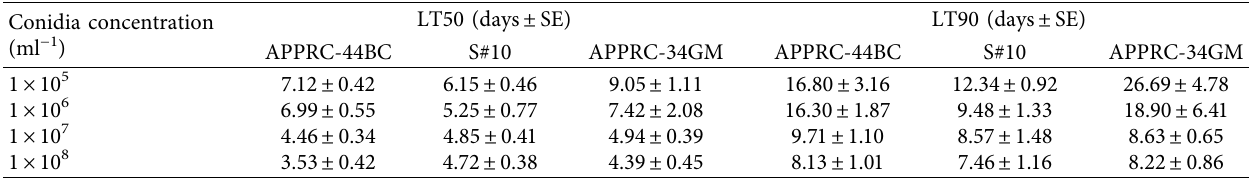
Figure 1: Mean percentage mortality of Chilo partellus larvae due to selected entomopathogenic fungi (EPF) strains. Isolates with ∗ were selected for dose response study and colonisation potential study. Table 3: LT50 and LT90 of C. partellus larvae treated with diferent conidial concentration of Beauveria and Metarhizium isolates, 11 days after treatment application.